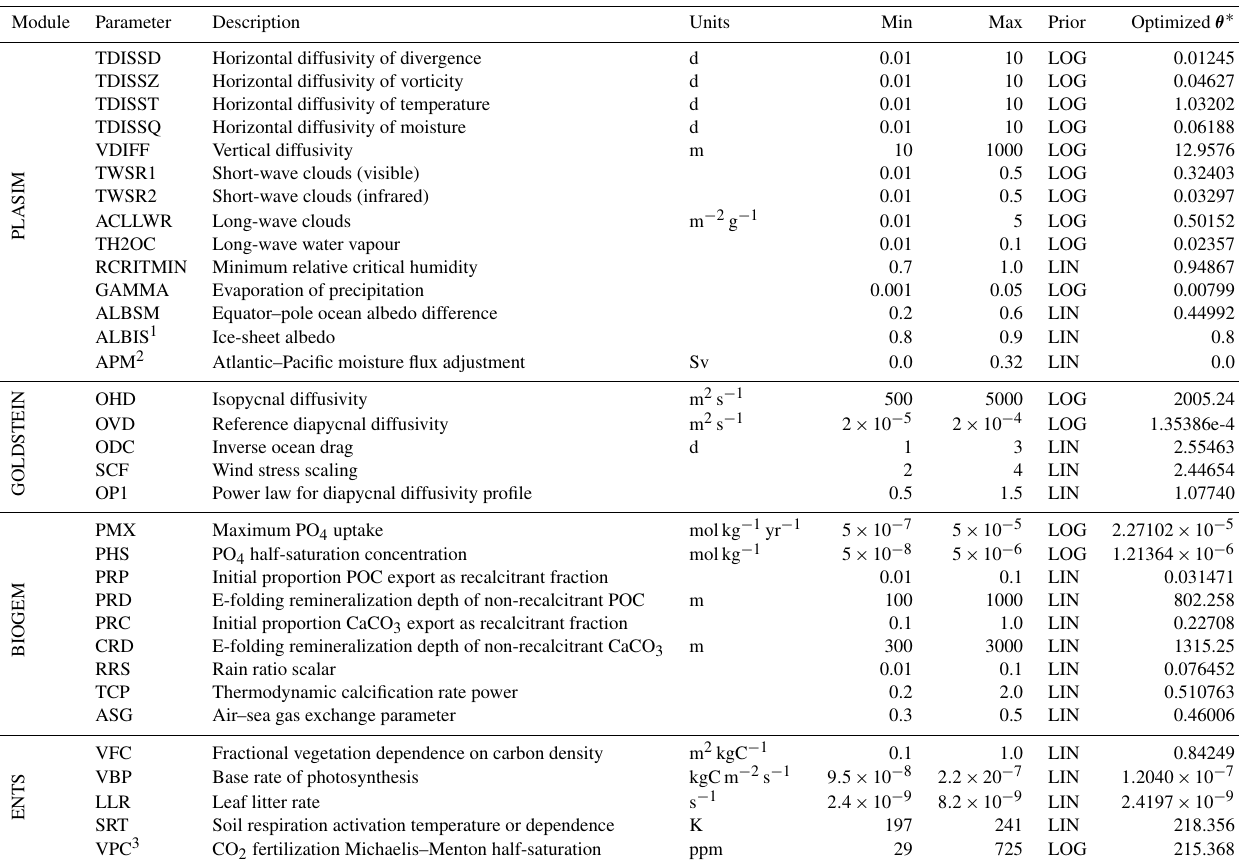
Table 2. Prior distributions for PLASIM-GENIE varied parameters (uniform between ranges in log or linear space as stated).Prior distri- butions are discussed and derived from Holden et al. (2010, 2013a, b, 2014, 2016). The final column tabulates the optimized parameter